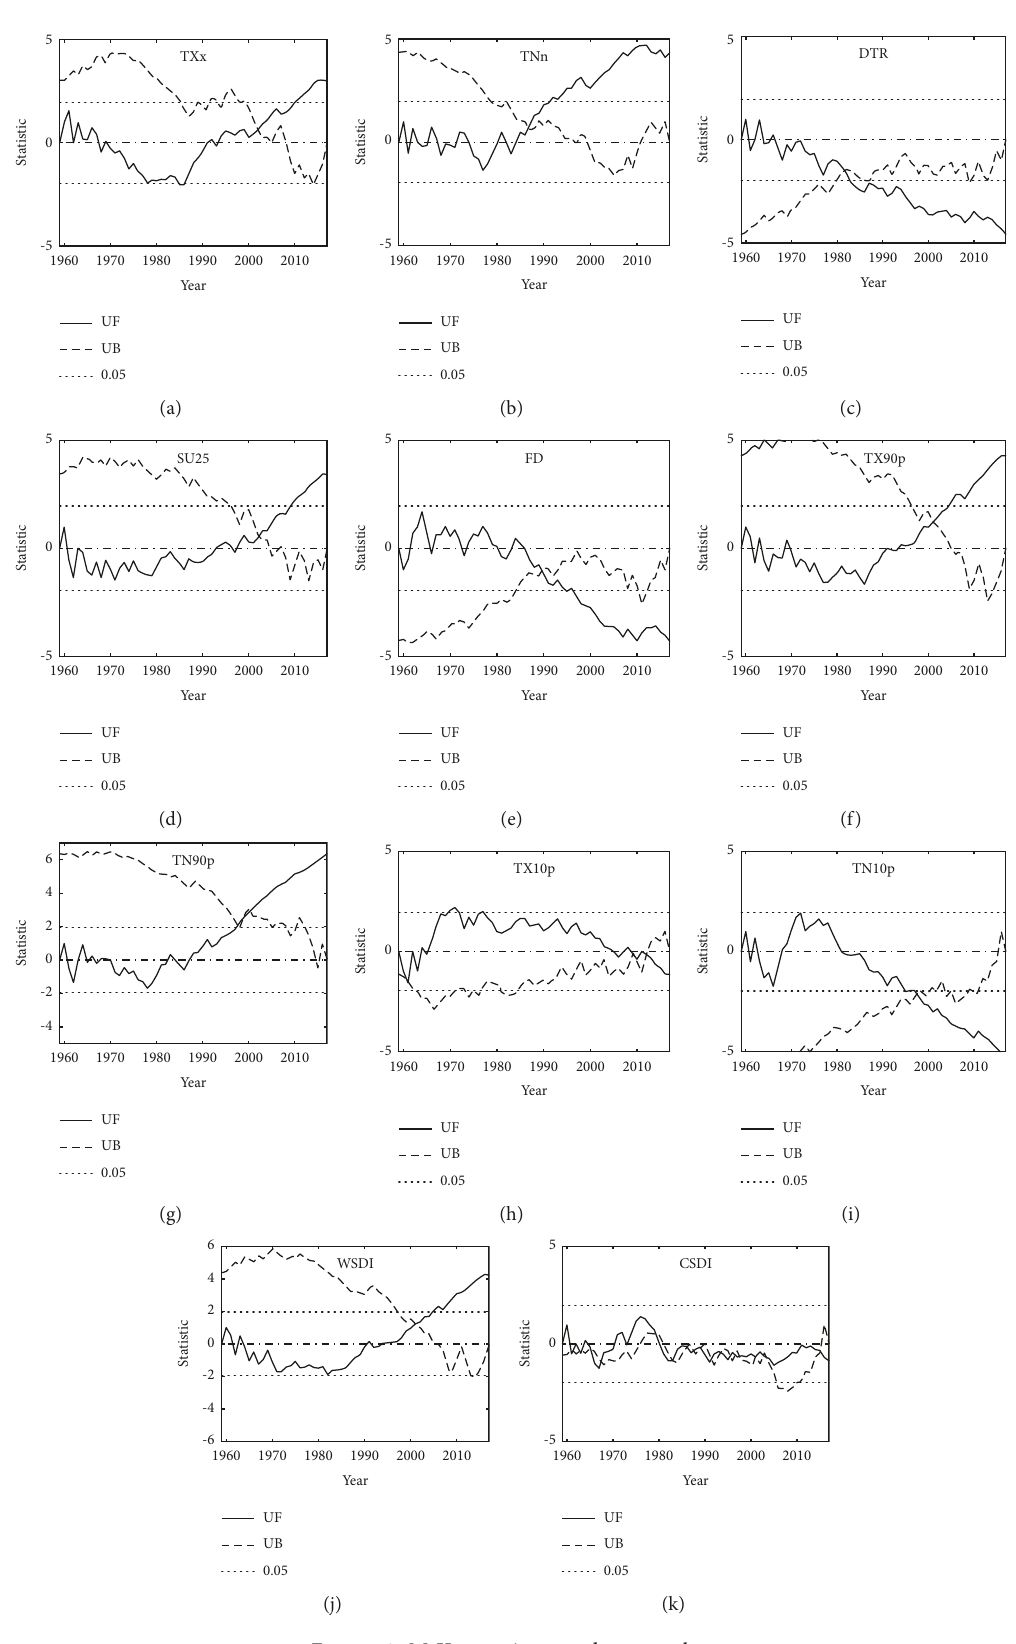
Figure 2: M-K mutation trend test